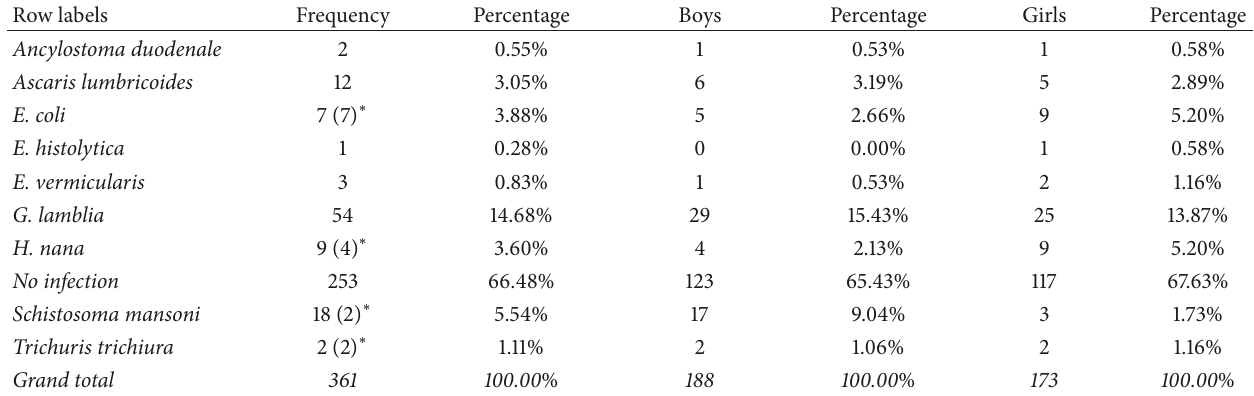
Table 4: Prevalence of parasitic infections in sampled study population in Mwea Division.